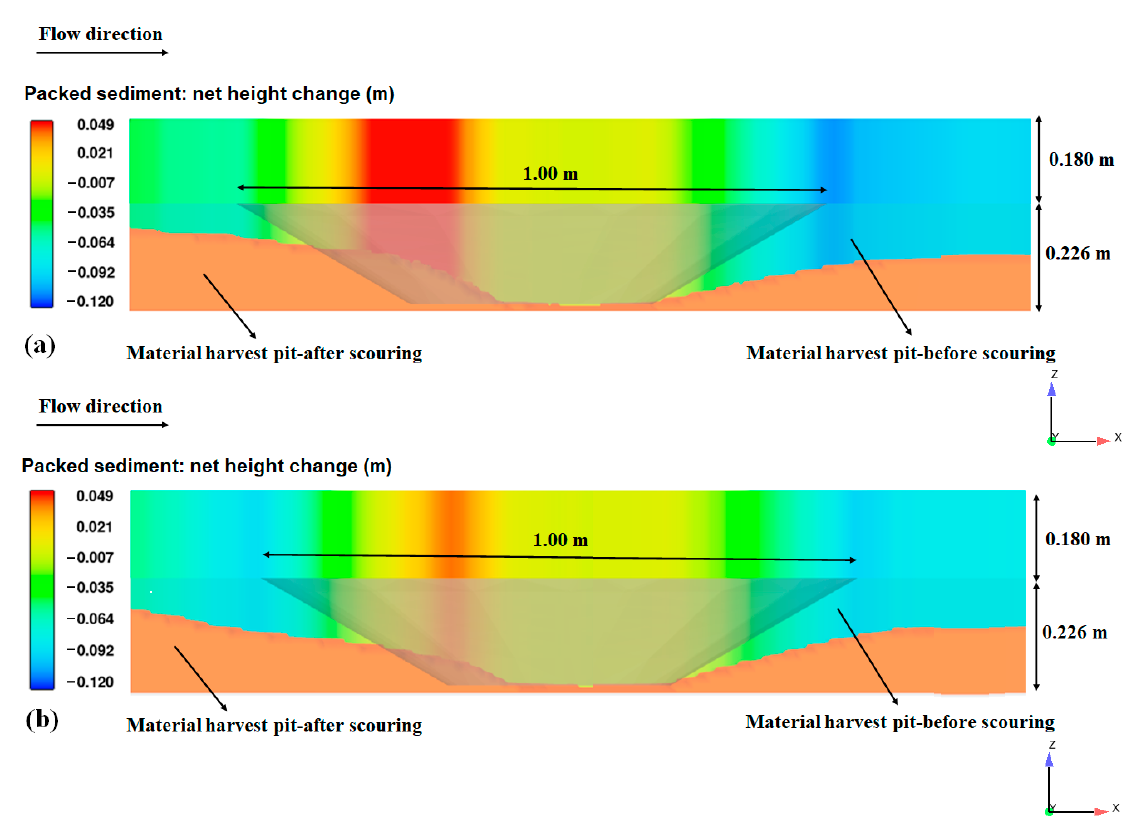
Figure 12. Material harvest pit changes in the x–z plane: ( a ) Circular model; ( b ) hydrodynamic model.